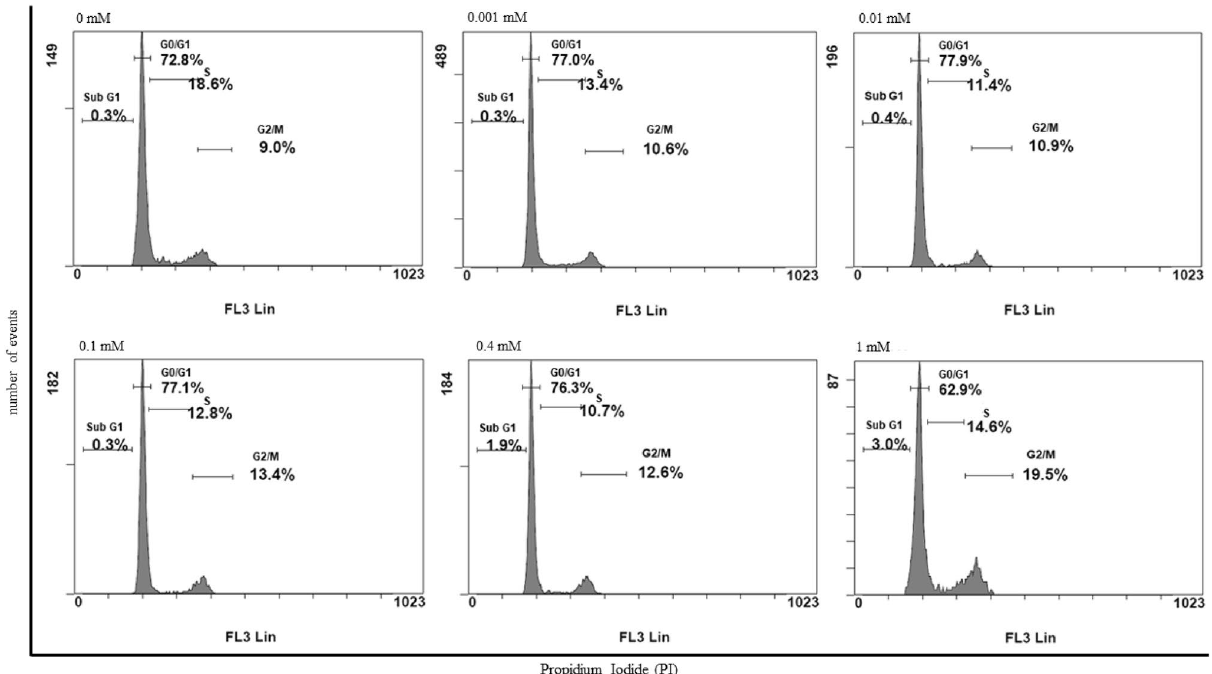
Figure 2. Representative results of cell cycle distribution of hMSCs treated with increasing doses of morphine sulphate for eighteen days and obtained by PI staining for flow cytometry. Graphs show changes in the percentage of cells at G1/0, S and G2/M in relation to the tested concentrations.